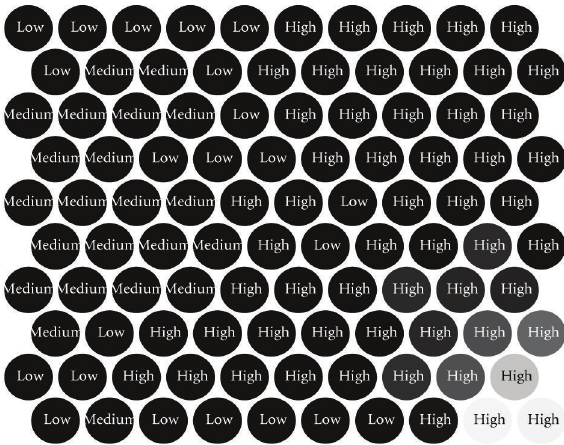
Figure 9: Plane map for token steal on Information Exposure.